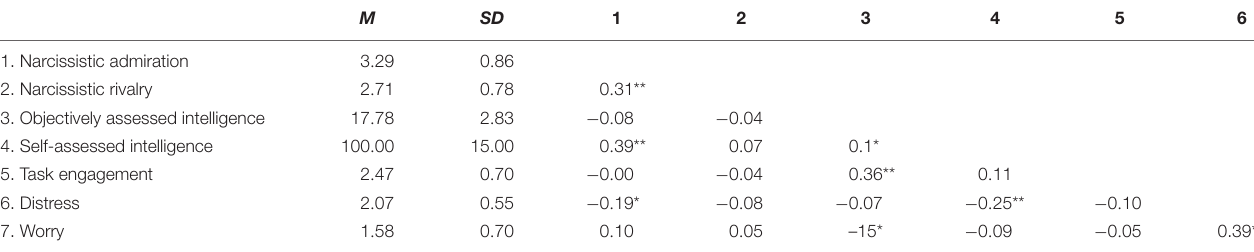
TABLE 1 | Correlations between narcissism, intelligence, self-assessed intelligence, and descriptive statistics. M SD 1 2